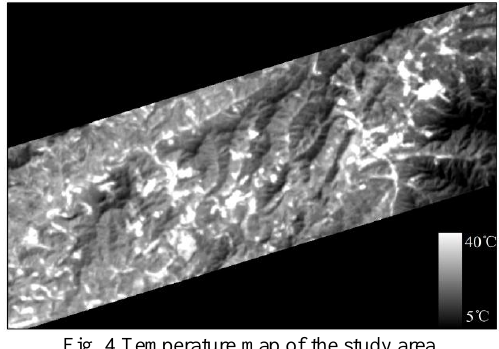
Fig. 4 Temperature map of the study area (2) Characteristics of annular heat island in tailings ponds There is also temperature difference between the tailings pond and the stope. The temperature of the tailings pond is higher than the stope on the whole. For spatial distribution, the distribution of temperature is more uniform in the stope, and the temperature of the tailings pond is annular and the central temperature is the highest (Figure 5). Tailings pond and stope can be distinguished based on the characteristics of the annular heat island in the tailings pond (Figure